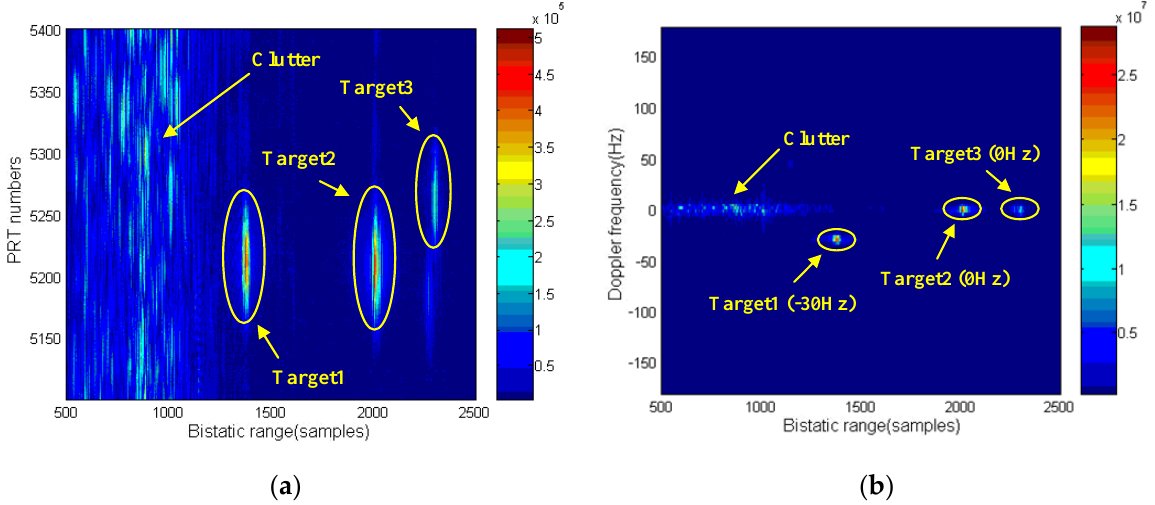
Figure 21. HBR map after magnification of the target area: ( a ) Range-azimuth map; ( b ) Range-Doppler (R-D) map .